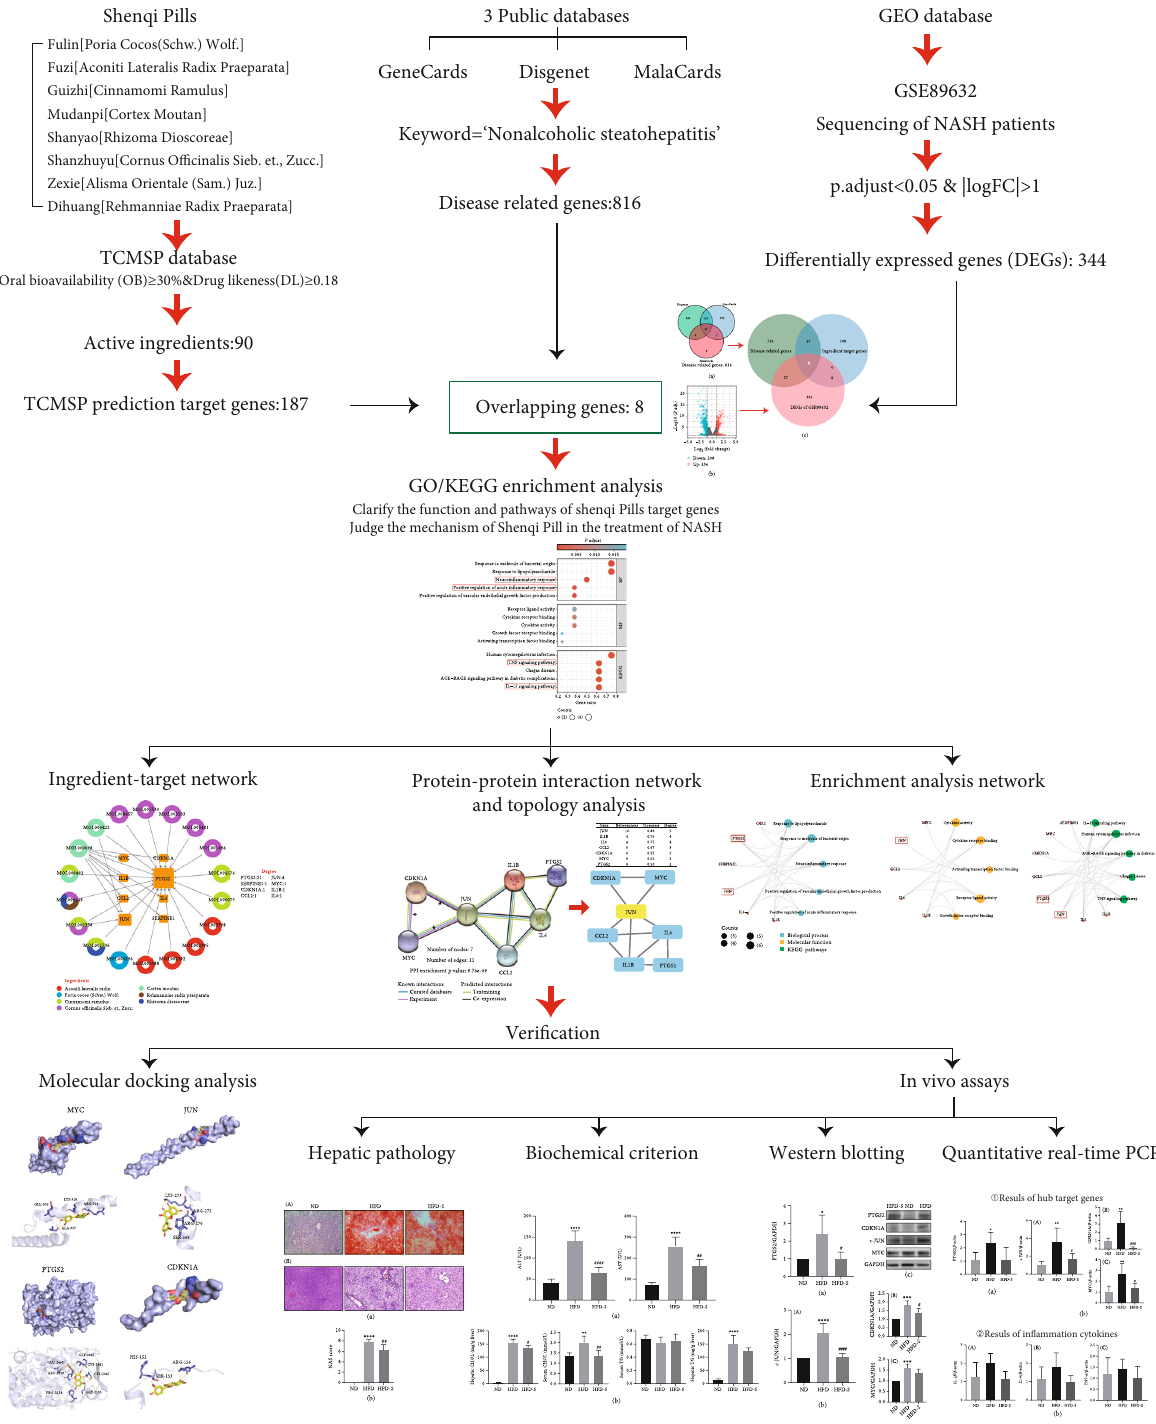
Figure 1: The analysis fl ow of the